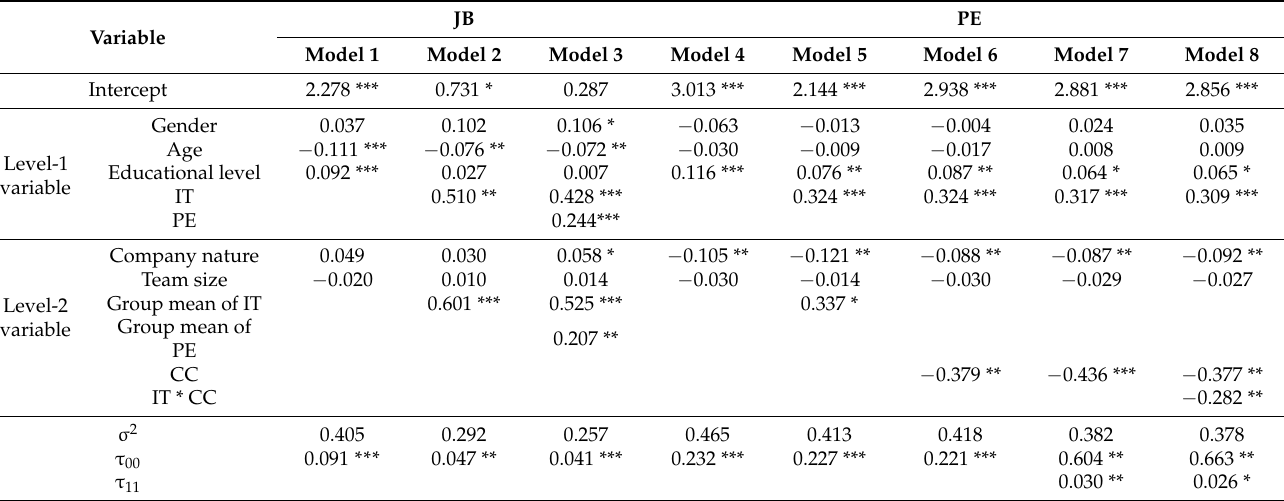
Table 4. The results of cross-level regression analysis for mediating